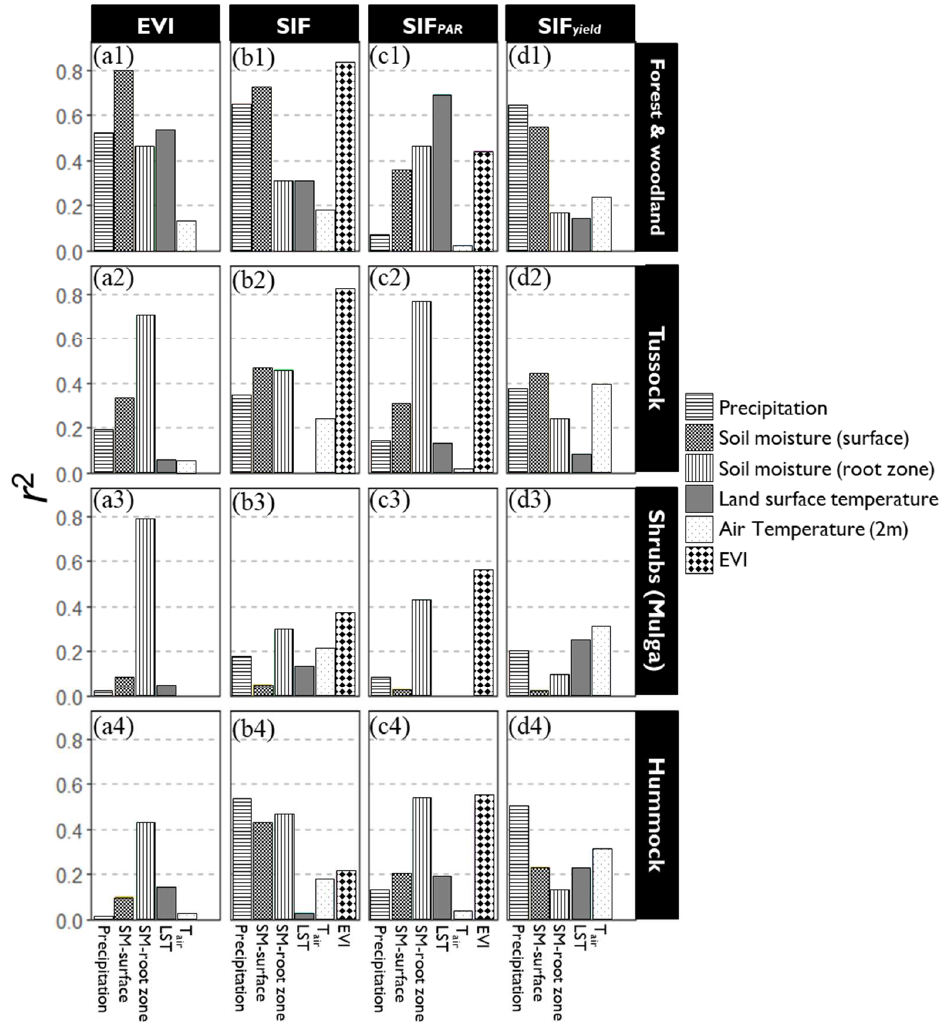
Figure 8. Relationships between climatic–environmental drivers and vegetation variables of ( a1 – a4 ) EVI, ( b1 – b4 ) SIF, ( c1 – c4 ) SIF PAR , and ( d1 – d4 ) SIF yield among four major biome types across the NATT during 2014–2019. ( p -value < 0.001).